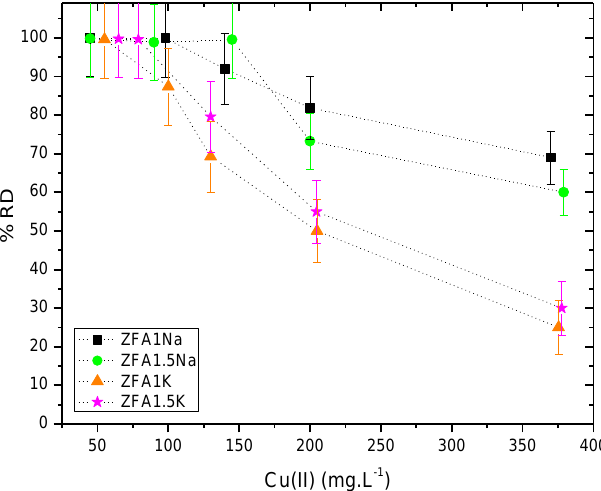
Figure 3. Removal e ffi ciency of all zeolites (ZFA1Na, ZFA1.5Na, ZFA1K, and ZFA1.5K) for di ff erent Figure 3. Removal efficiency of all zeolites (ZFA1Na, ZFA1.5Na, ZFA1K, and ZFA1.5K) for different initial Cu(II) ion concentrations (dosage, 0.5 g · L − 1 ; 25 ◦ C). initial Cu(II) ion concentrations (dosage, 0.5 g·L −1 ; 25 °C).